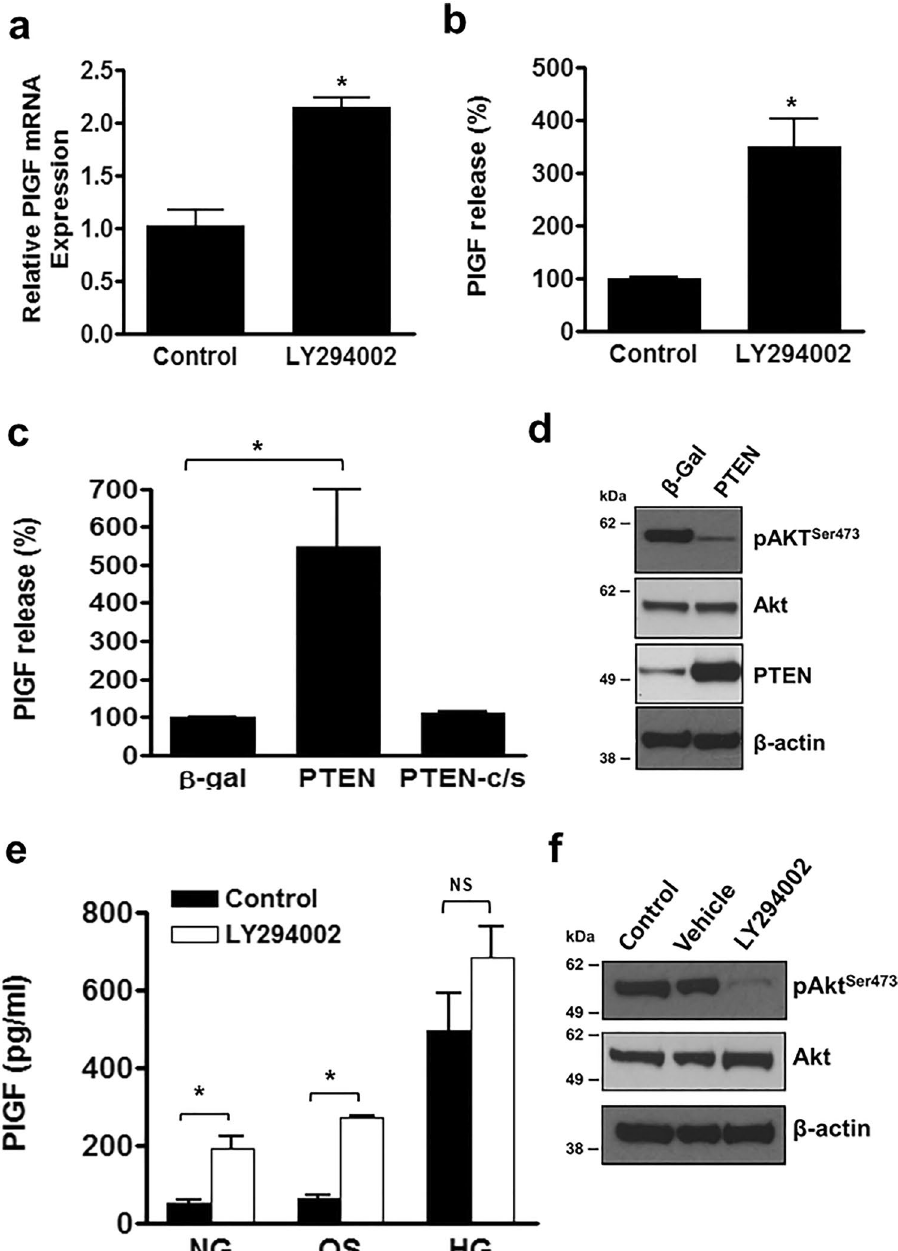
Figure 2. Inhibition of the PI3K pathway promotes PlGF expression and secretion. Confluent HUVEC pre-treated with LY294002 (20 µM) and incubated for ( a ) 8 h or ( b ) 24 h and PlGF mRNA quantified by qPCR and protein secretion by ELISA. ( c ) HUVEC were infected overnight with adenoviruses encoding PTEN, mutant PTEN (PTEN-c/s), or β-galactosidase (β-gal). Following 24-h incubation ( c ) PlGF levels in the culture medium were quantified by ELISA. ( d ) Western blots confirming inhibition of Akt activity in HUVEC following Ad-PTEN infection. ( e ) HUVEC treated with LY294002 or the vehicle and incubated for 24 h in normoglycaemia (NG = 5 mM d-glucose), hyperglycaemia (HG = 30 mM d-glucose), or osmolarity control (OS = 5 mM d-glucose + 25 mM l-glucose), and PlGF measured in supernatants by ELISA. ( f ) Representative Western blots of the HUVEC lysates following treatment of HUVEC with LY294002 or the vehicle for one hour showing pAkt Ser473 , total Akt with β-actin as a loading control. The unedited blot images are presented in Supplementary Fig. S5. Results are the mean ± SEM of 3 or more experiments (n > 6), Student t-test; *P < 0.05, **P <